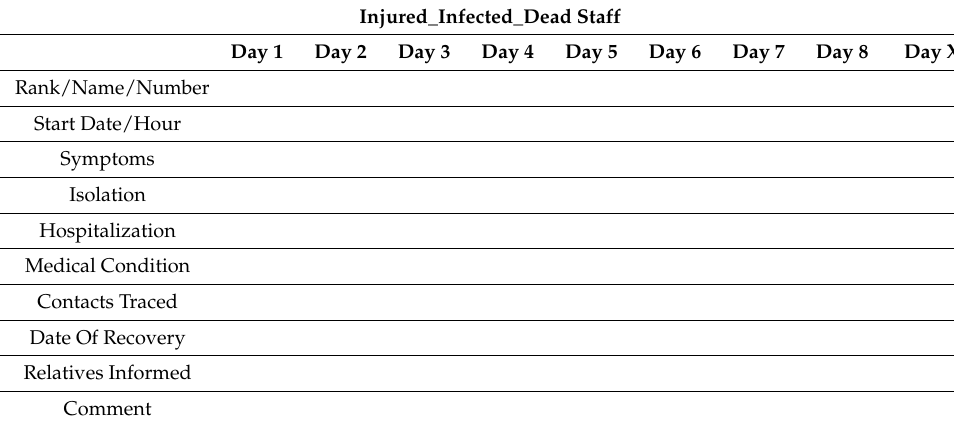
Table 7. A checklist to record the epidemiological data for